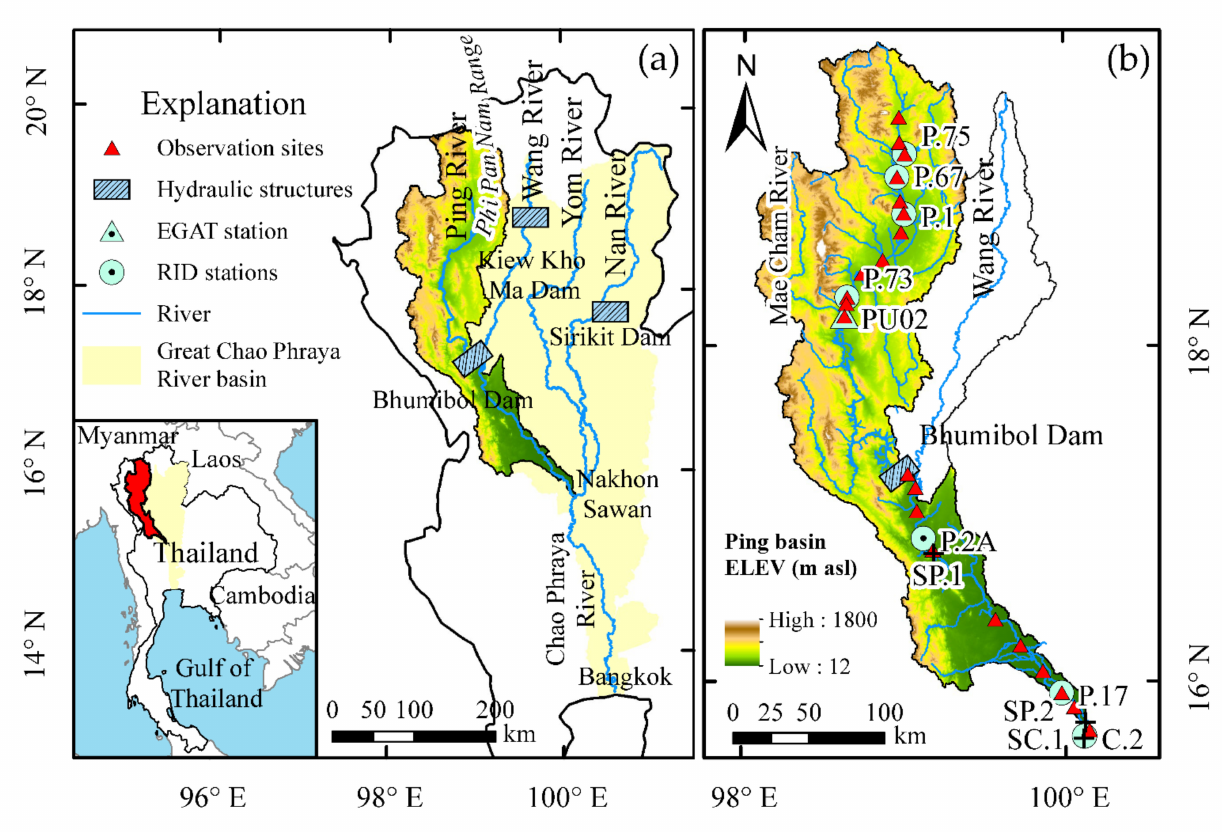
Figure 1. Map of the Chao Phraya River Basin, Thailand: ( a ) Ping River Basin and location of the Bhumibol Dam, the largest dam in the Chao Phraya River system; ( b ) locations of observation sites and hydrological stations operated by the Royal Irrigation Department (RID) and the Electricity Generating Authority of Thailand